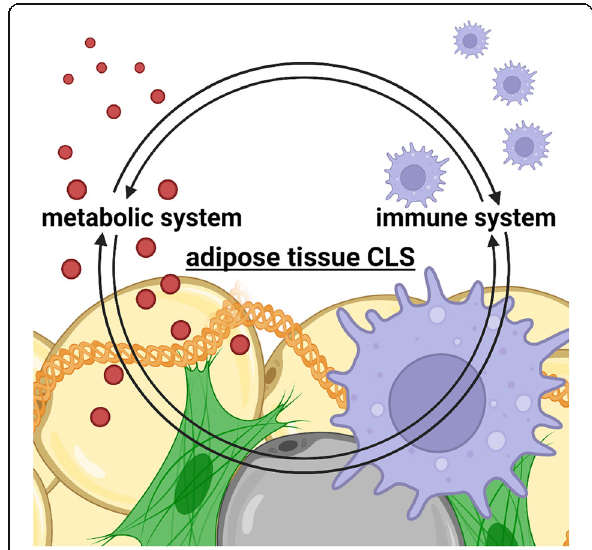
Fig. 3 An interface between immune and metabolic systems: adipose tissue CLS. Immune cells infiltrate adipose tissue in response to body weight gain, induce chronic inflammation in adipose tissue, and affect the functions of remote organs, such as the liver, through aberrant adipokine production. In this regard, the CLS serves as a driving engine to induce metabolic inflammatory responses in obese adipose tissue (adipose tissue CLS). Intriguingly, a similar structure occurs in the liver in the progression from simple hepatic steatosis to NASH (hepatic CLS). Thus, the considerable attention to the interface between immune and metabolic systems has led to the emerging concept of “ immunometabolism. ” Created with